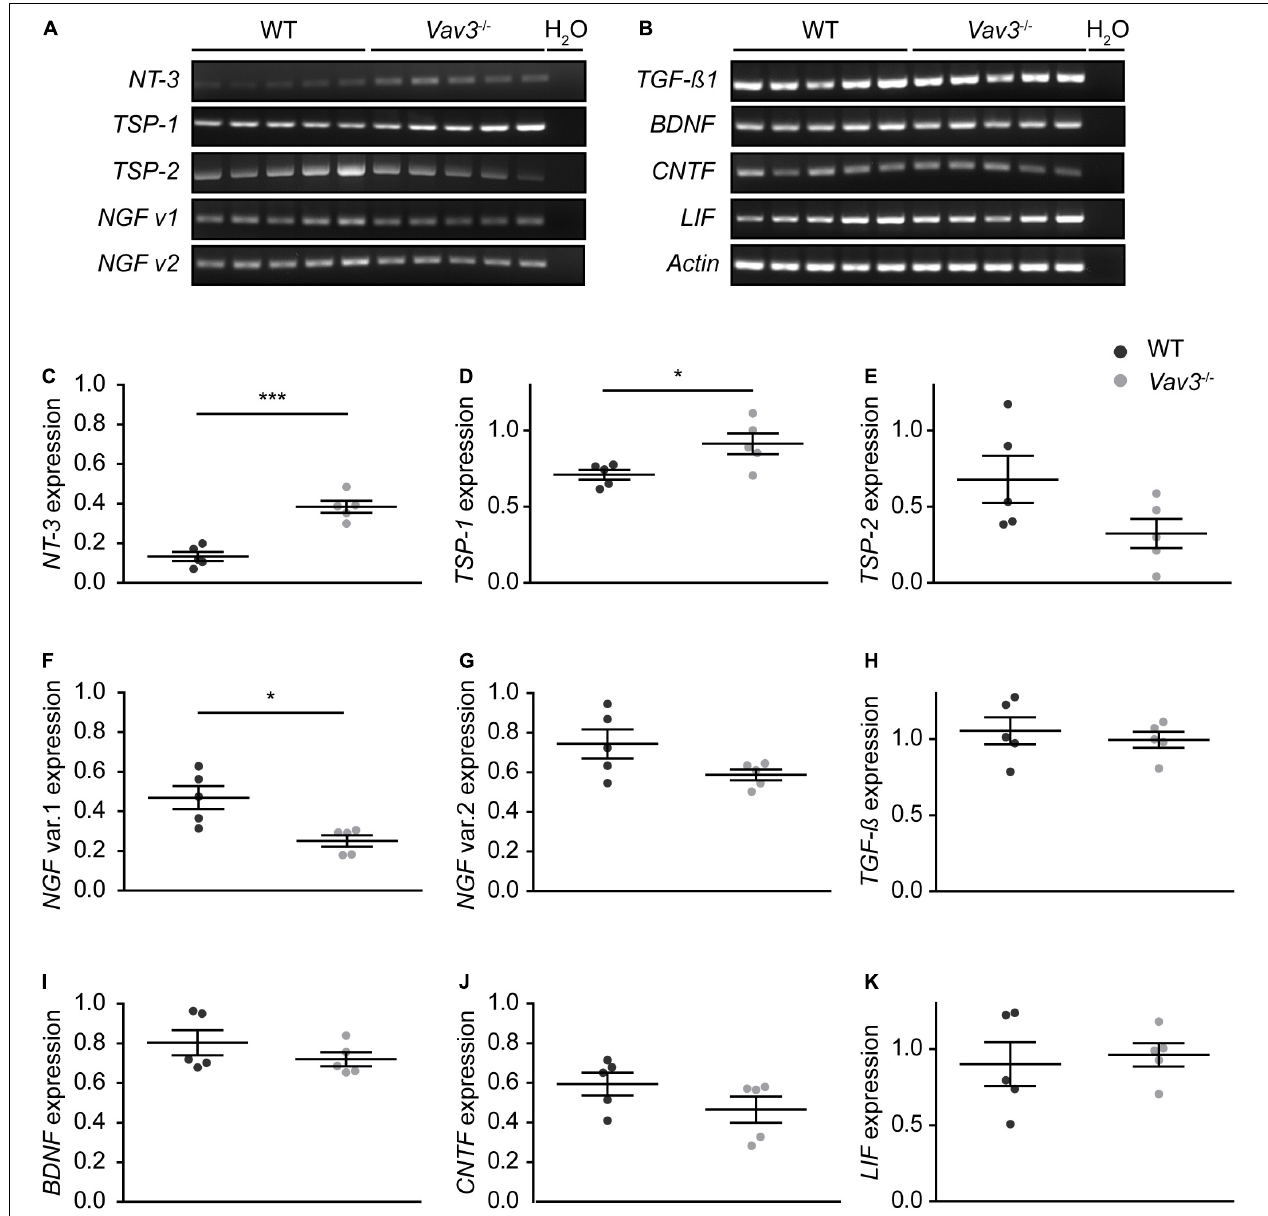
FIGURE 4 | (A,B) Wildtype and Vav3 − / − astrocytes were lysed and a RT-PCR analysis with primers for different neurotrophic factors was performed. The signal intensity of NT-3 appeared stronger in Vav3 − / − astrocytes compared to wildtype astrocytes. Furthermore, there was a slightly reduced signal intensity of the transcript variant 1 of NGF in Vav3 − / − astrocytes. (C–K) The signal intensity of the PCR bands was set in relation to the actin positive control and compared between both groups. The quantification revealed a significantly increased expression of NT-3 and TSP-1 while the transcript variant of NGF was reduced. The expression of all other analyzed neurotrophic factors was unchanged in the knockout condition. Individual dots are representing the signal intensity of every sample in relation to actin Statistics: in total, five independent experimental repetitions ( N = 5) were performed and one lysed sample ( n = 1) per repetition was used for the PCRs. Unpaired t -test; * p ≤ 0.05, ** p ≤ 0.01 and *** p ≤ 0.001, data are represented as mean ±